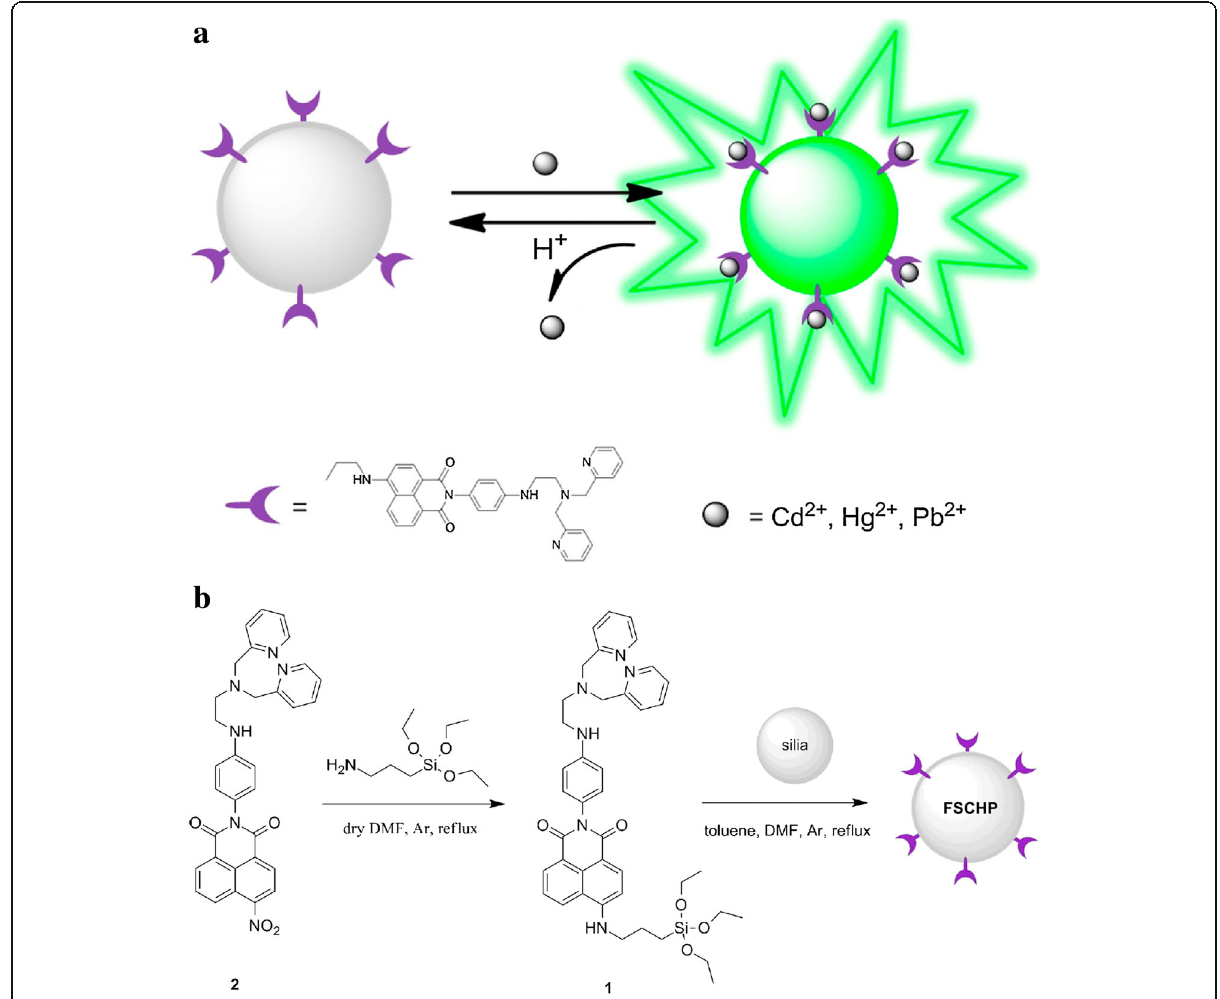
Fig. 20 The formation and sensing progress scheme of sensitive fluorescent sensor (FSCHP)